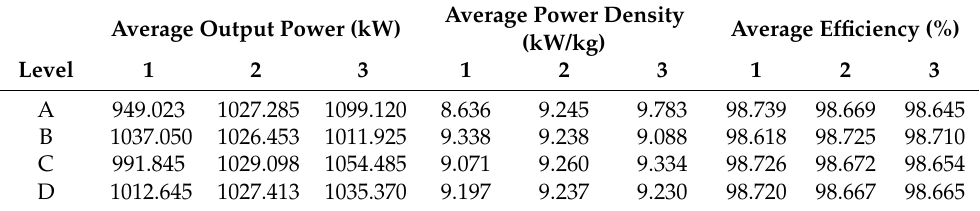
Table 8. Average values of output power, power density, and efficiency under different level values. Average Power Density Average Efficiency (%) Average Output Power (kW) (kW/kg) Level 1 2 3